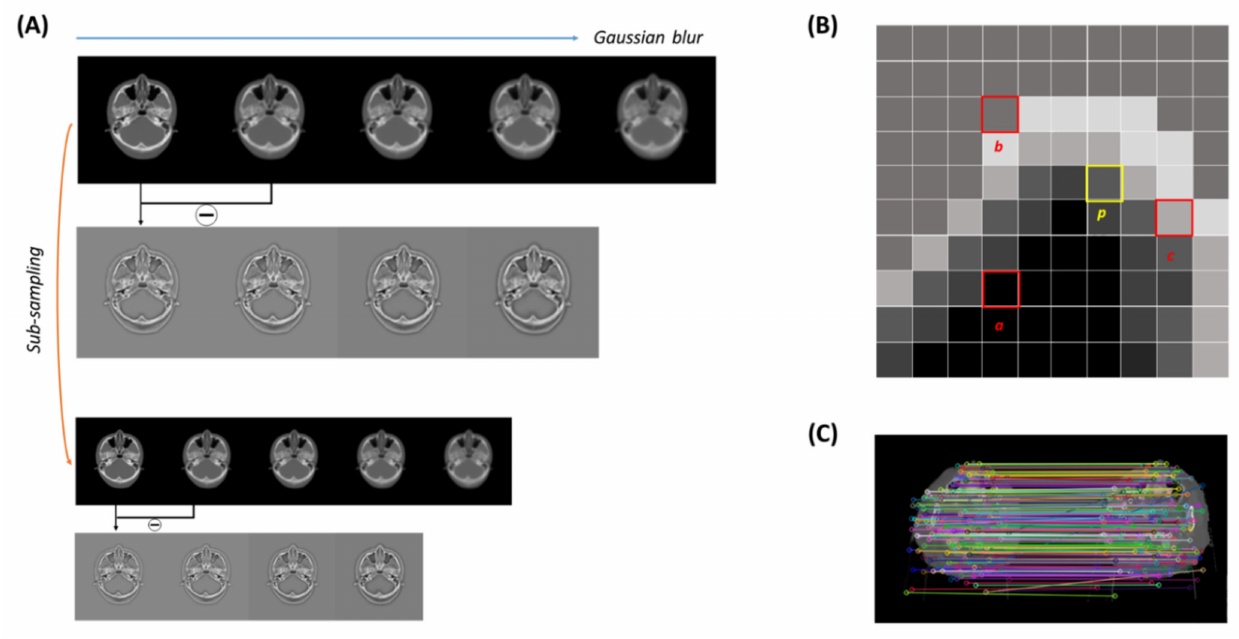
Figure 2. Feature mapping ratio (FMR). ( A ) Example of detect feature point. To detect the feature point, the difference image between adjacent Gaussian blurring images is used and the local extrema position is used as the feature point. ( B ) Example of binary descriptor. The binary number is calculated as 110(2) by points a, b, and c around the feature point p. 110(2) means information that b is brighter than a, c is brighter than b, and a is darker than c. ( C ) The binary descriptor determines the similarity using a Hamming